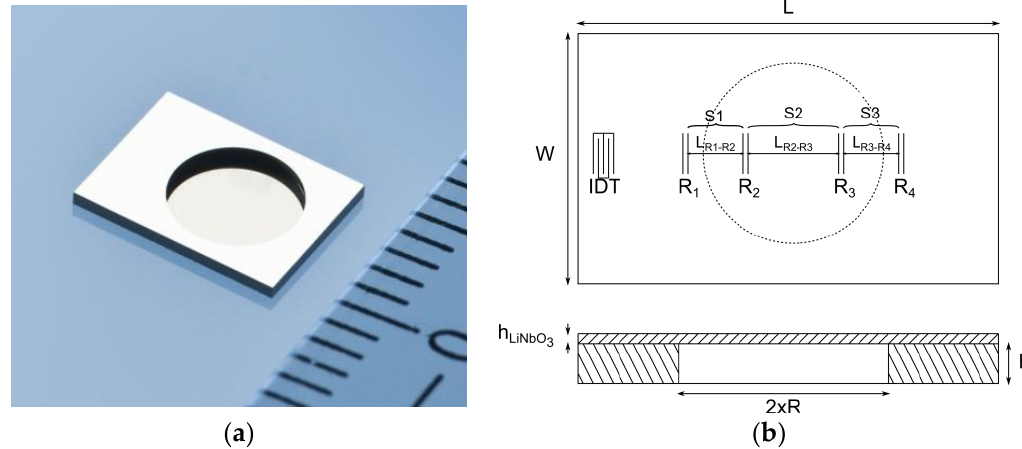
Figure 1. Membrane-based LN/Si Surface Acoustic Wave (SAW) pressure sensor: ( a ) pictured from below. The Inter Digital Transducer (IDT) and reflectors are located on the other side of the element. The membrane is 30 µ m-thick. Its diameter is 4.7 mm; ( b ) R-DL and sensor design (schematics).